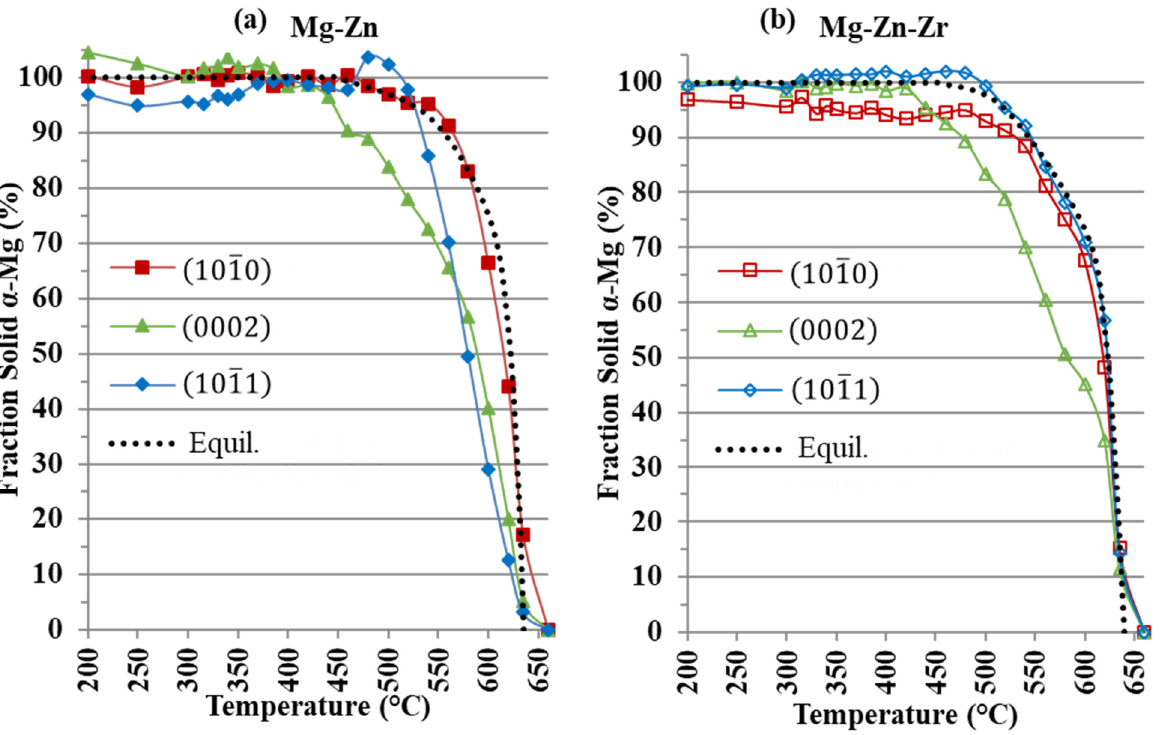
Figure 8. Fraction solid (%) versus temperature of ( a ) α -Mg for Mg-Zn and ( b ) α -Mg for Mg-Zn-Zr. For the Mg-Zn alloy in Figure 8a, the more packed ( 0002 ) and